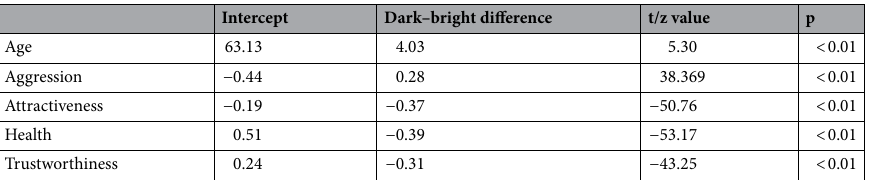
Table 1. Summary of the models for each of our dependent variables. The model for age is a linear regression with error structure. All other models are generalized linear models with error